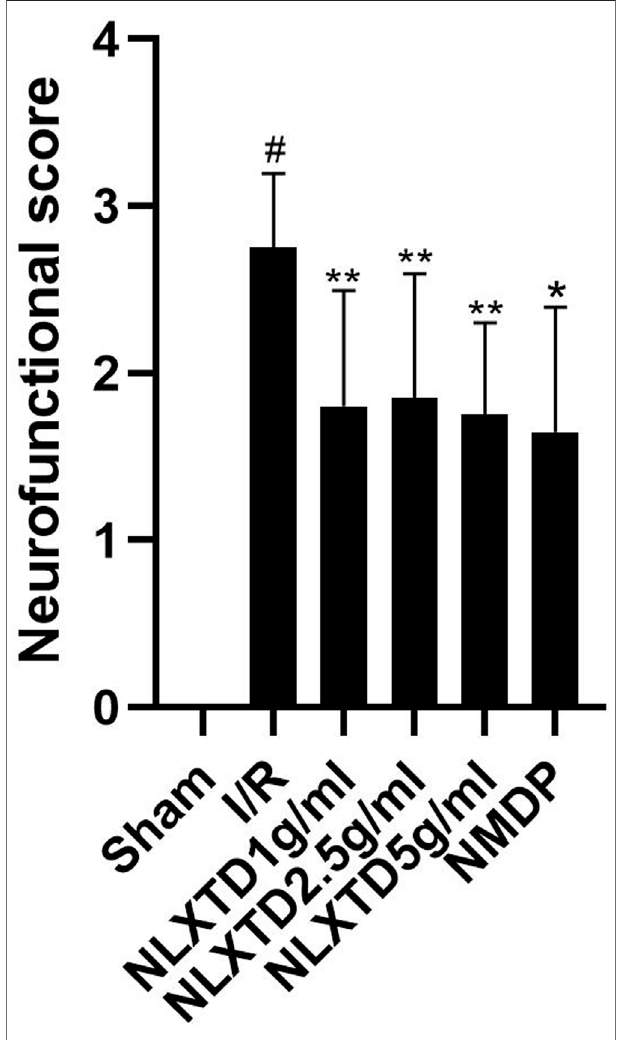
FIGURE 4 | Neurofunctional score analysis of NLXTD. Notes: # p < 0.01 vs. Sham group; * p < 0.01, ** p < 0.05 vs. I/R group.